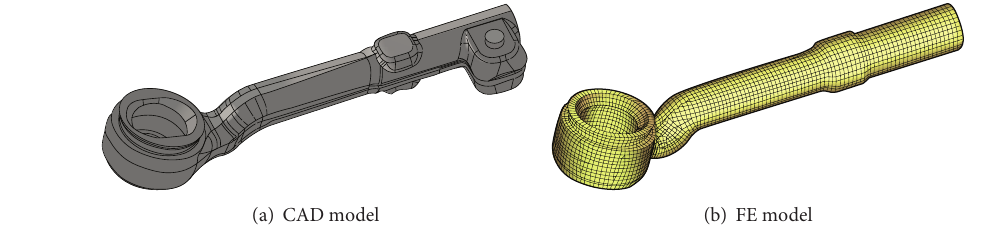
Figure 1: The base model of steel OTR.